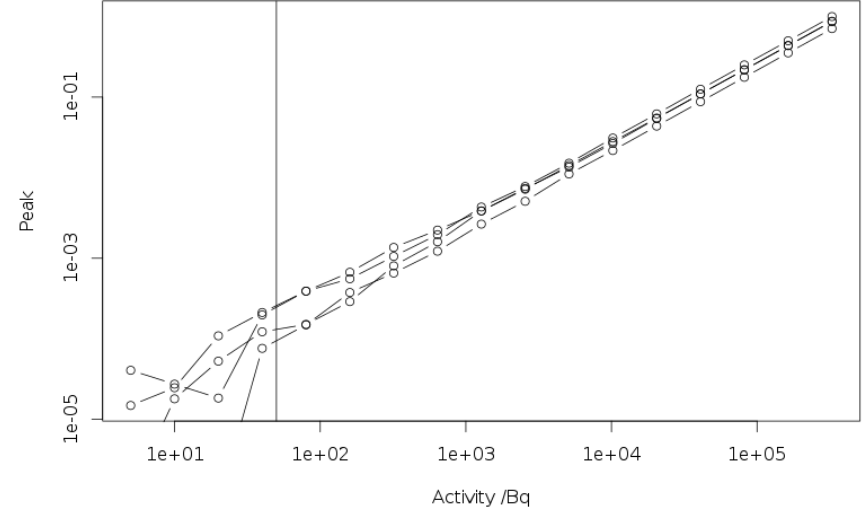
Figure 5. Peak amplitudes of the four point sources in Fig. 4 with dependence on the total activity.